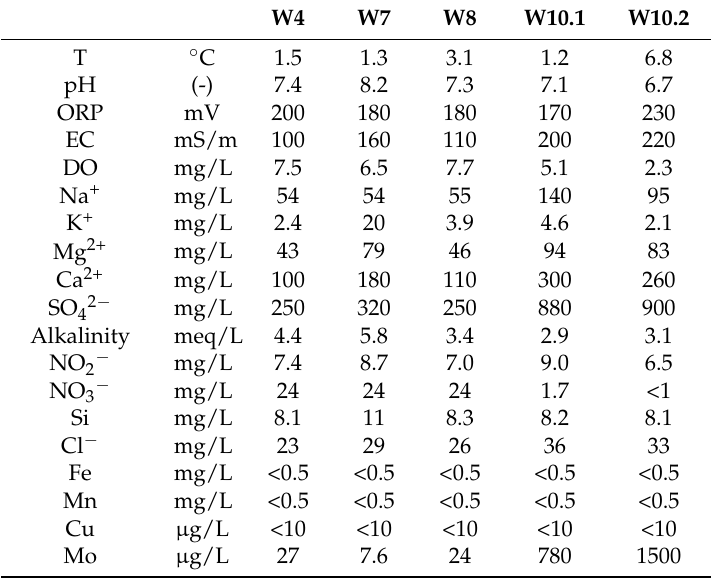
Table 2. Water chemistries from river (W4, Erdenet River; W7, Gavil River; and W8, Khangal River) and pond (W10.1 and W10.2)